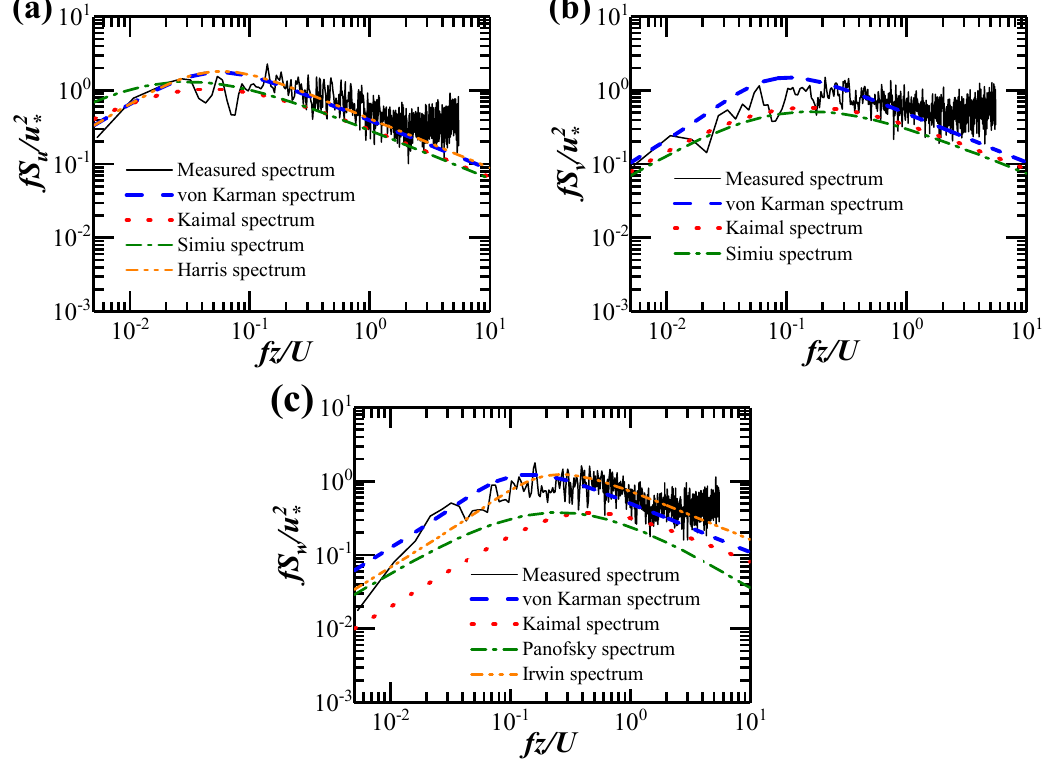
Figure 8. Wind spectra obtained via the field measurement: ( a ) Longitudinal velocity; ( b ) Lateral velocity; ( c ) Vertical velocity.